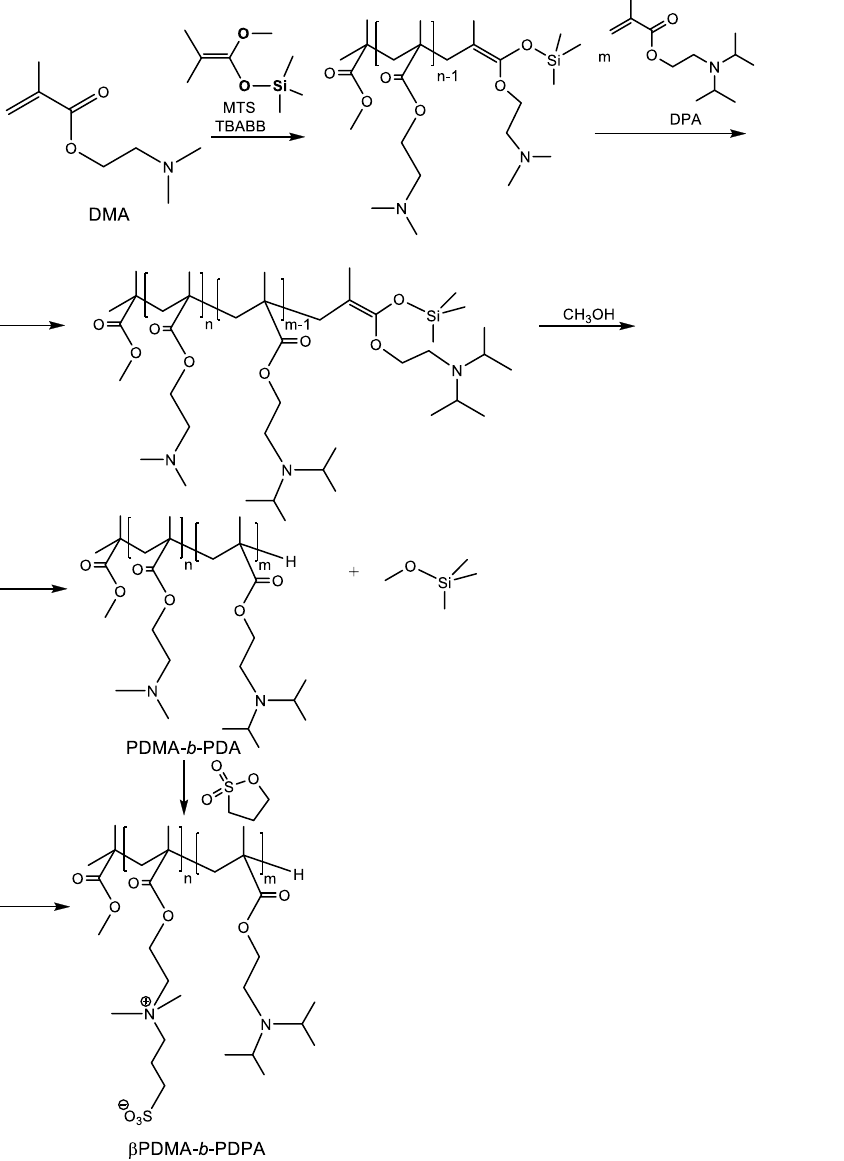
copolymer micelles, the building blocks for further construction of mono and multilayered